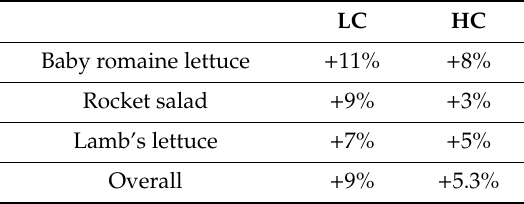
◦ 30 C (log CFU / g) was observed (slope = 0.30; maximum analysis time = 30 h; R 2 = 0.79) (Figure 3).